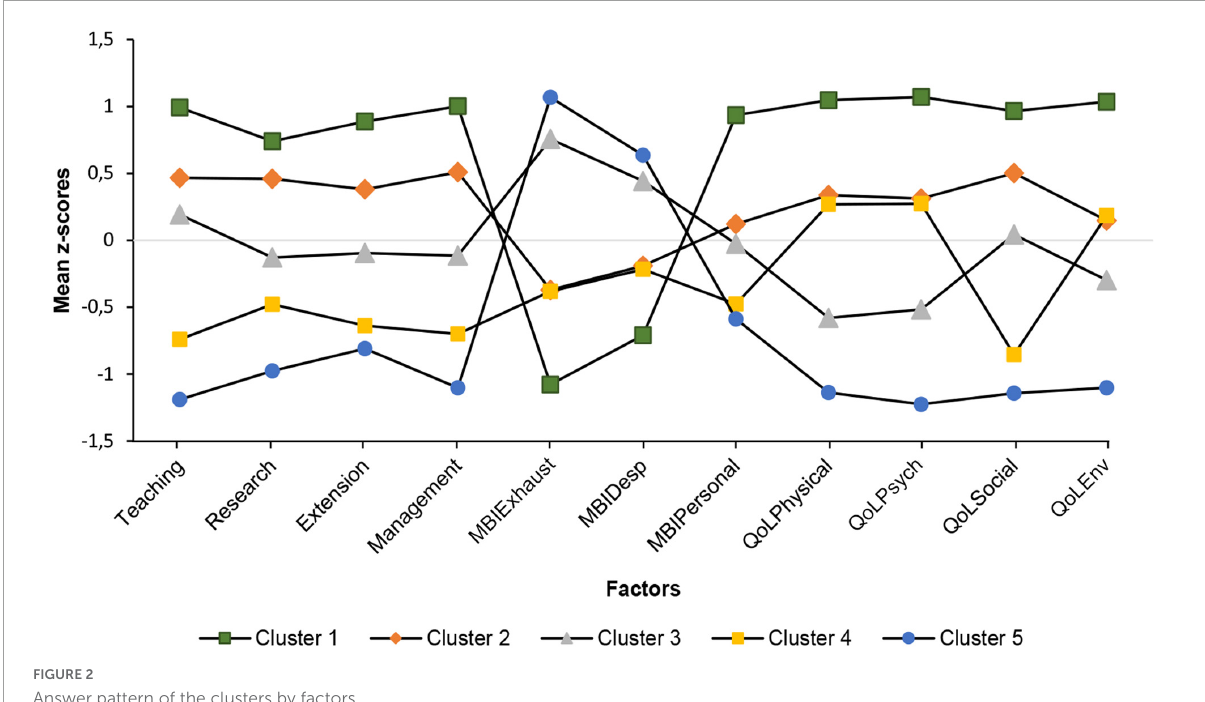
FIGURE2 Answer pattern of the clusters by